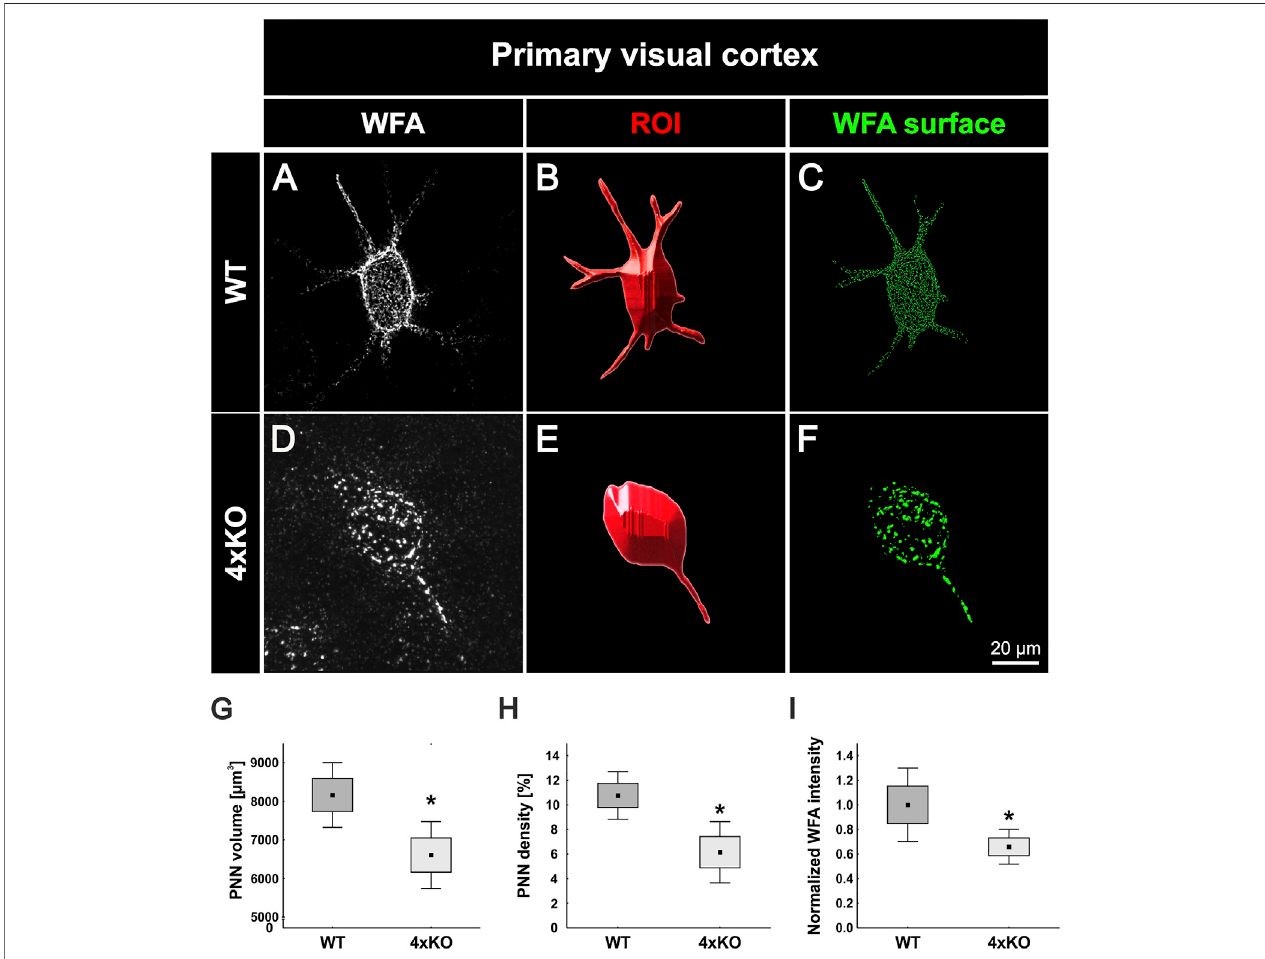
FIGURE 2 | Structural characterization of PNNs in the V1 of wildtype and quadruple knockout mice using super-resolution SIM. (A and D) Representative SIM image of WFA-positive PNNs in the wildtype and quadruple knockout V1. As depicted exemplarily, the wildtype PNN showed a typical honeycomb structure with WFA- positive proximal dendrites. In contrast, the quadruple knockout PNN showed a disorganized structure with only one WFA-positive process. (B and E) Using IMARIS software,a3D surfacewas generated manually containingtheWFA-positive signal and the somaenveloped bythe PNN,which wasdeterminedasROI. (C and F) IMARISsurfacetechnologywasthenusedtocreate3DsurfacesoftheWFA-positivesignalinsidetheROIbestmatchingPNNanatomy.TheWFAsignaloutsidetheROI wassuppressed. (G) Quantitativeanalysisrevealedasigni fi cantreductioninthevolumeofquadrupleknockoutPNNsincomparisontowildtypePNNs( p < 0.05). (H and I) . In addition, PNN density ( p < 0.05) and WFA intensity ( p < 0.05) were signi fi cantly reduced in the quadruple knockout ( p < 0.05), indicating fewer WFA-positive PNN components on the cell surface of PNN-enwrapped neurons in the quadruple knockout. 4xKO, quadruple knockout; ROI, region of interest; WFA, Wisteria fl oribunda agglutinin; WT, wildtype, N = 8, * p < 0.05 data are shown as mean ± SEM and SD, scale bar = 20